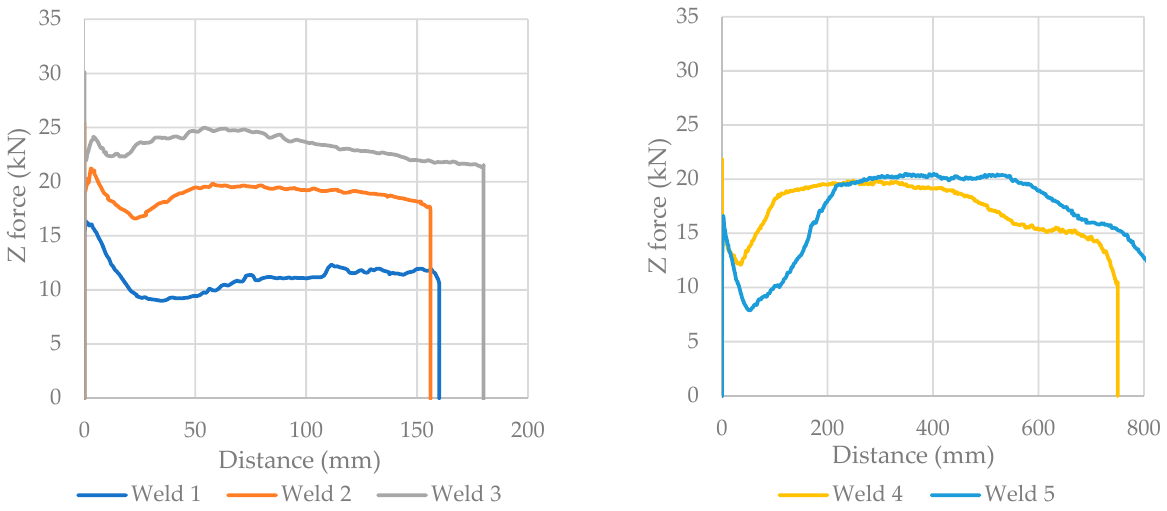
Figure 8. Axial force against weld length .